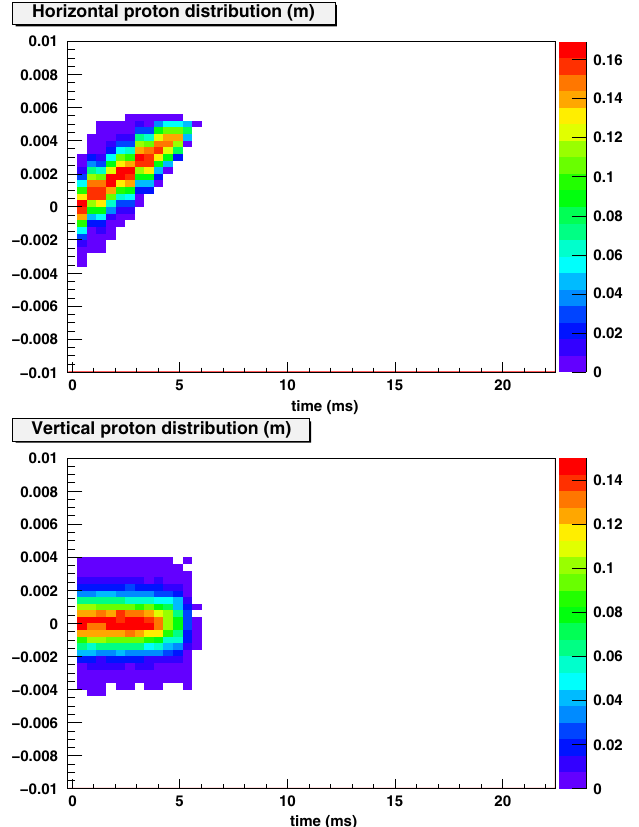
FIG. 10. (Color) The horizontal and vertical proton distribution at the TOTEM roman pots as a function of time, for a circuit error in RD1.LR1. The calculation was made for a 450 GeV stored beam with nominal collision optics. The color scale shows, in arbitrary units, the particle density in the